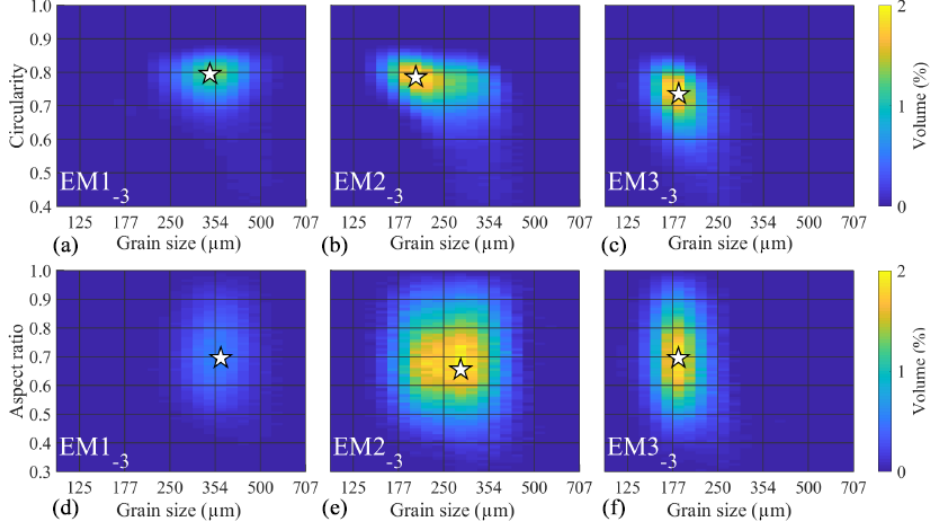
Figure A13. CcD2d (a–c) and ArD2d (d–f) 3EM solutions determined for the dune dataset.